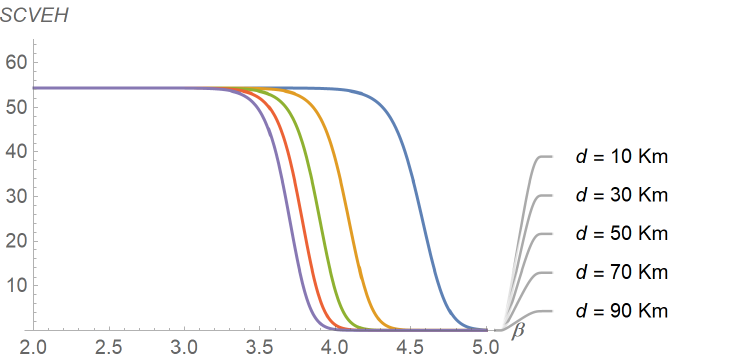
Figure 9. Evolution of the squared coefficient of variation in terms of the path-loss exponent, for different distances. The shadowing spread and the Nakagami parameter have been set to 8.5 and 5.0, respectively. The outermost curve corresponds to d = 10,000 m.